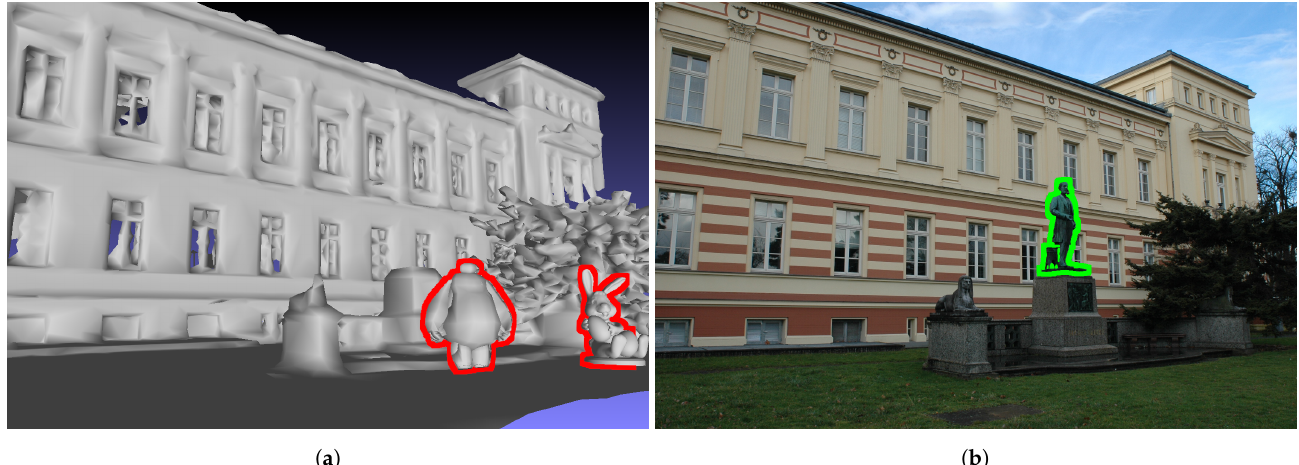
Figure 1. Insertions (green) and removals (red) over time. ( a ) Outdated 3D mesh, ( b ) up-to-date scene photograph.